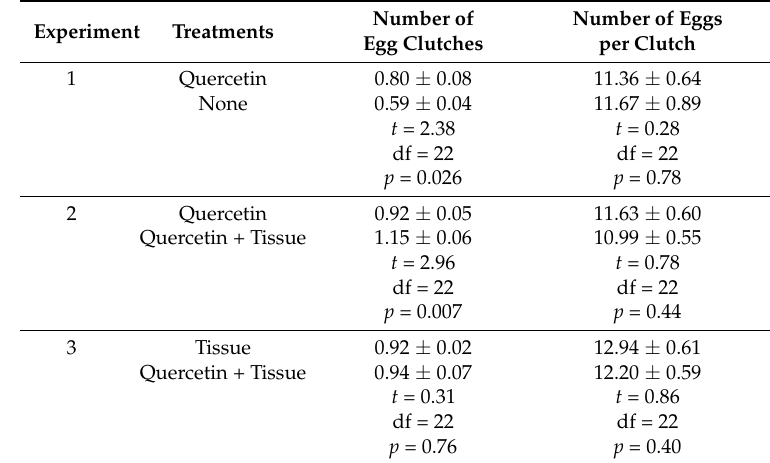
Table 2. Mean ( ± SE) number of egg clutches per C . maculata female per day and mean ( ± SE) number of eggs per clutch, regardless of oviposition site, in solitary 1